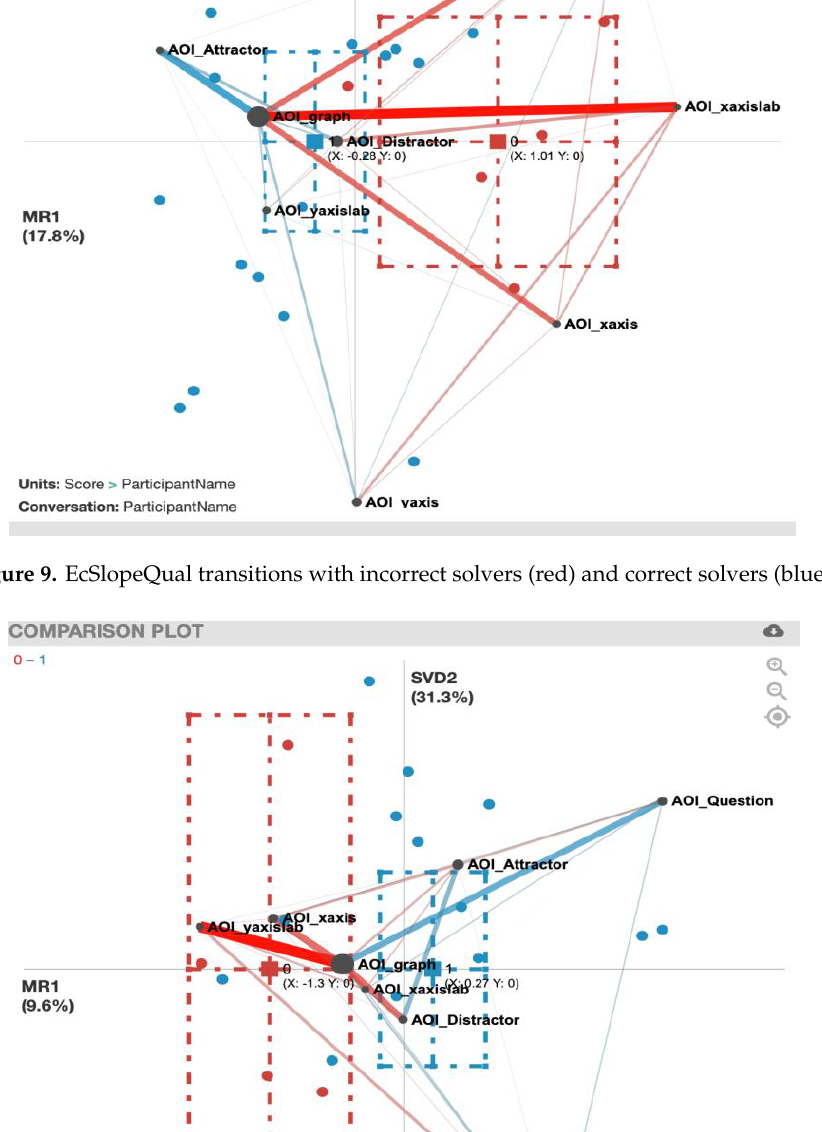
Figure 11 . EcSlopeQuant transitions with incorrect solvers (red) and correct solvers (blue).